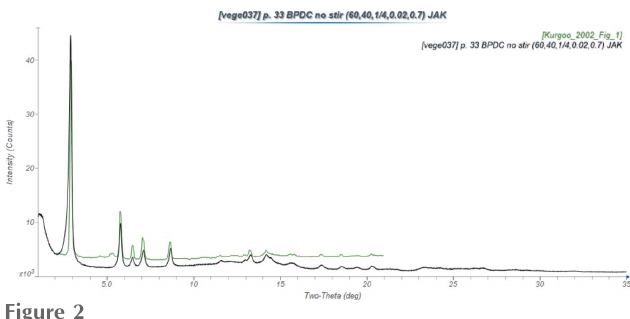
Figure 2 Comparison of the powder pattern of the Co 2 BPDC(OH) 2 of this study (black) to that reported by Kurmoo & Kumagai (2002; green). The literature pattern (measured using Cu K (cid:3) radiation) was digitized using